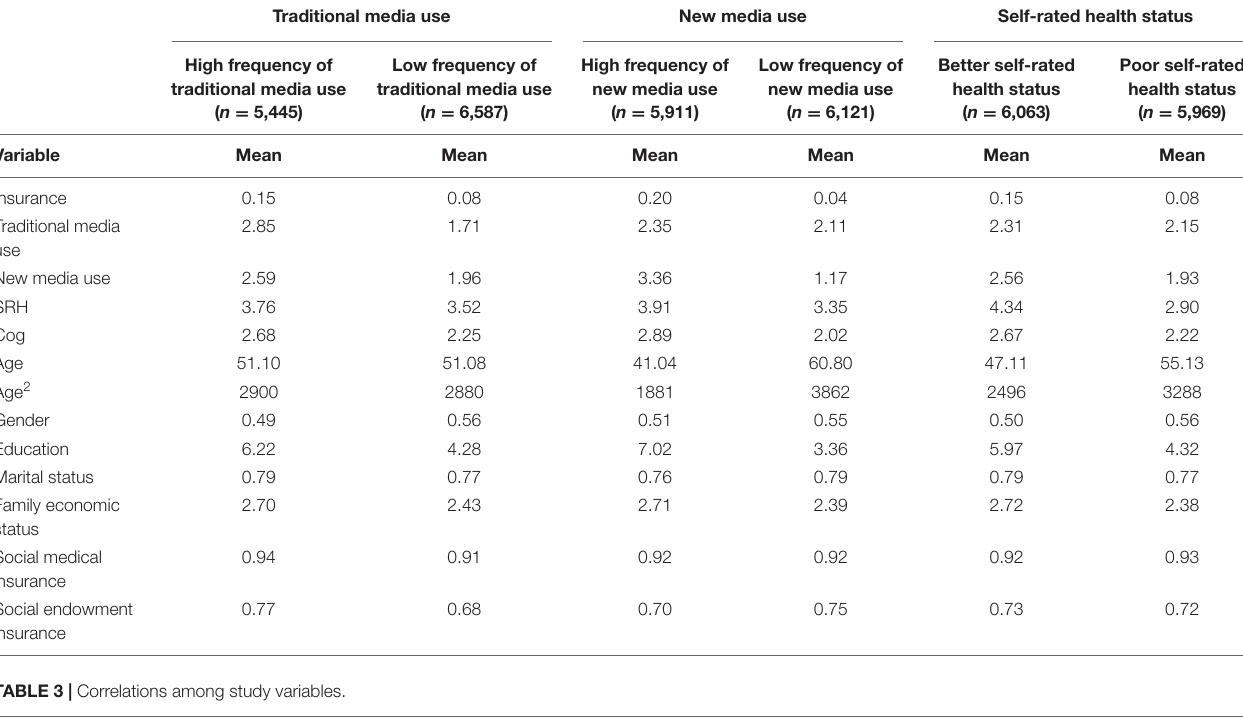
TABLE 2 | Descriptive statistics grouped by the frequency of traditional and new media use and self-rated health status.